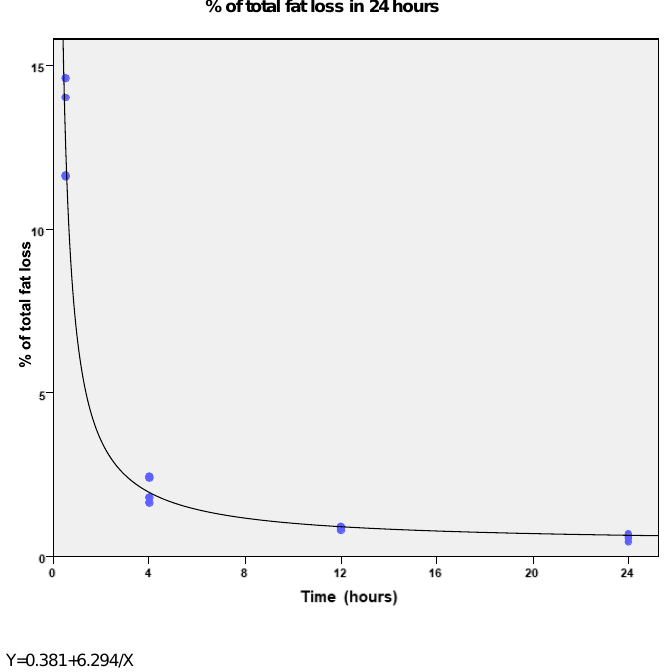
Figure 1. Amount of the total fat loss as % of the fat adsorbed in the tube in relation with the total fat infused during 24 h.